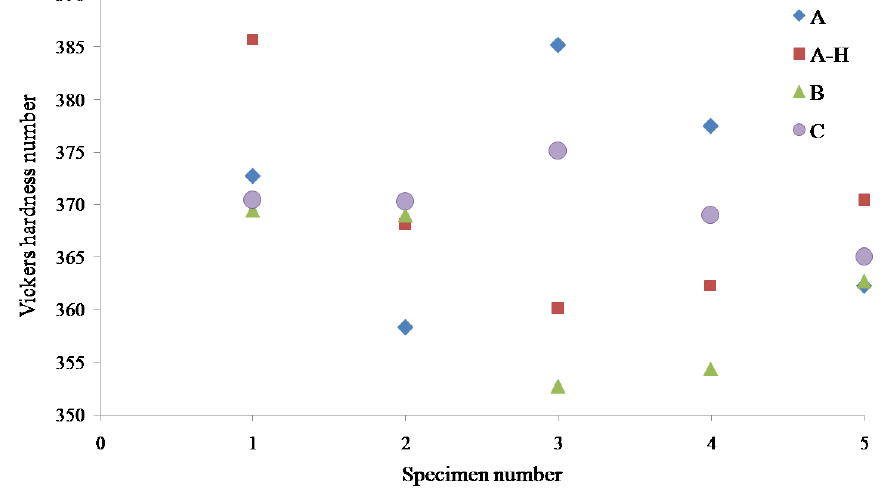
Figure 9. Hardness test results of Ti6Al4V material